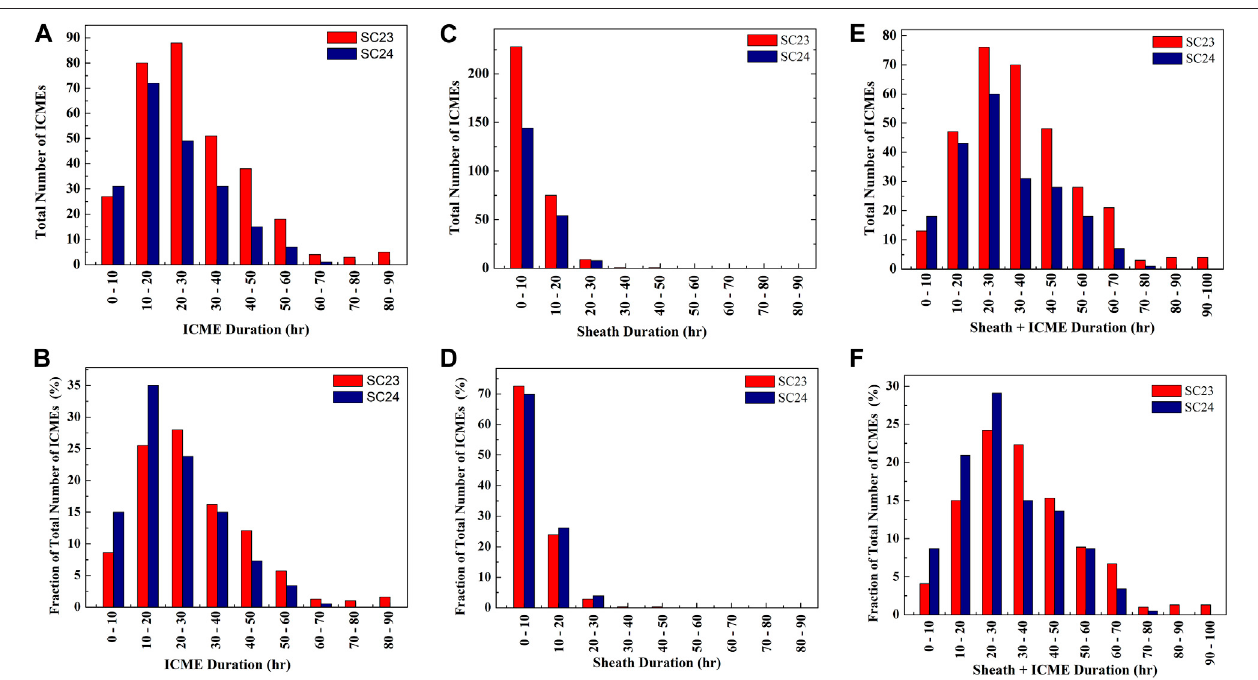
FIGURE1| ThedistributionsofdurationofICMEstructures,i.e.,ICMEs,sheathregionprecedingICMEs,andICMEstogetherwithsheath(i.e.,entiretransients)are shownin (A),(B),(C),(D) ,and (E),(F) ,respectively,forbothsolarcycles23and24. (A),(C),(E) and (B),(D),(F) showthedistributionsforthetotalnumberofICMEsandthe percentage fraction of the total number of ICMEs in each bin of duration,